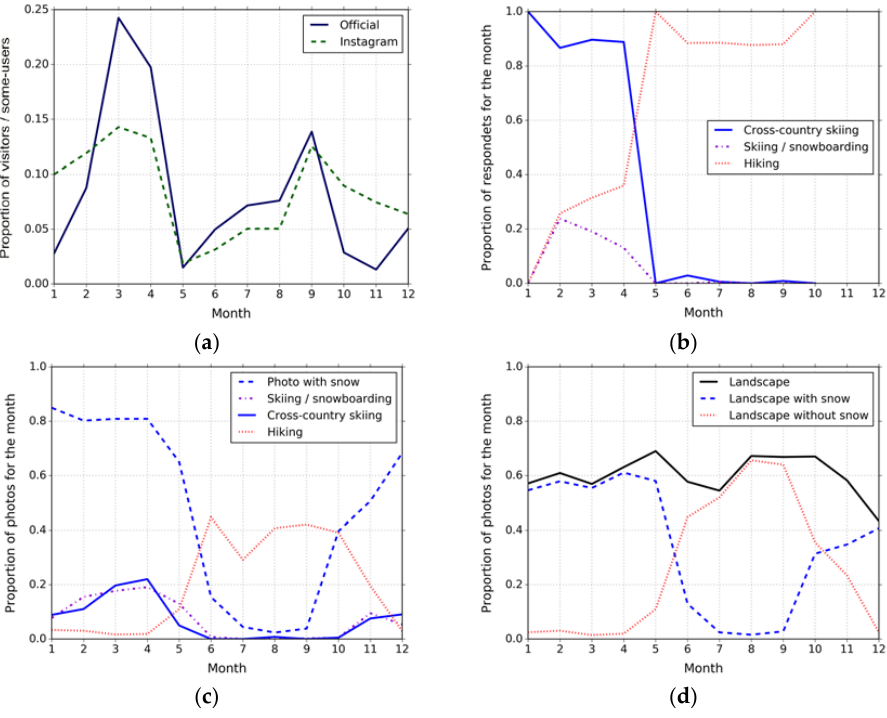
Figure 4. The proportion of respondents/Instagram photos per activity in PY National Park. Activities are sorted by popularity in the survey.